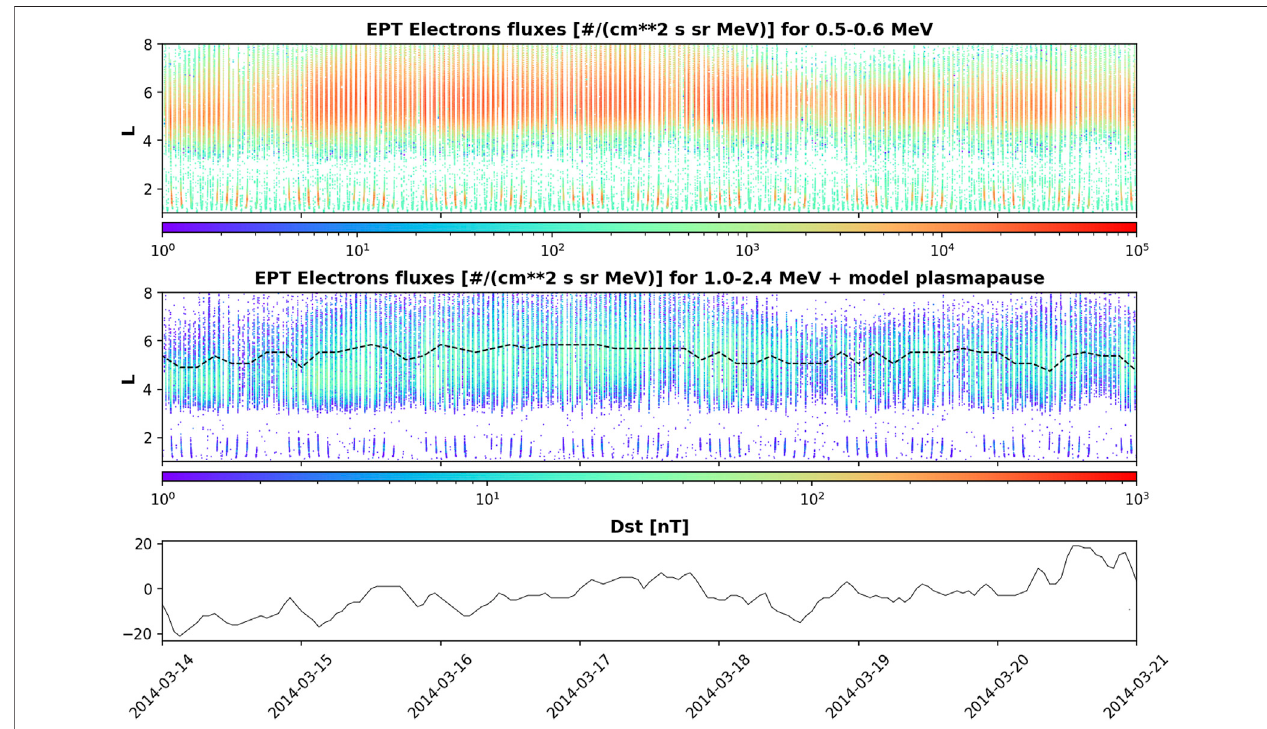
FIGURE 6 | Upper panel: Electron fl ux measured by PROBA-V/EPT at 500 – 600 keV from 14 to March 20, 2014. Middle panel: Electron fl ux measured by PROBA-V/EPT at 1 – 2.4 MeV from 14 to March 20, 2014. The black dotted line in the middle panel corresponds to the plasmapause obtained from the SPM model. Bottom panel: Observed Dst index during the same